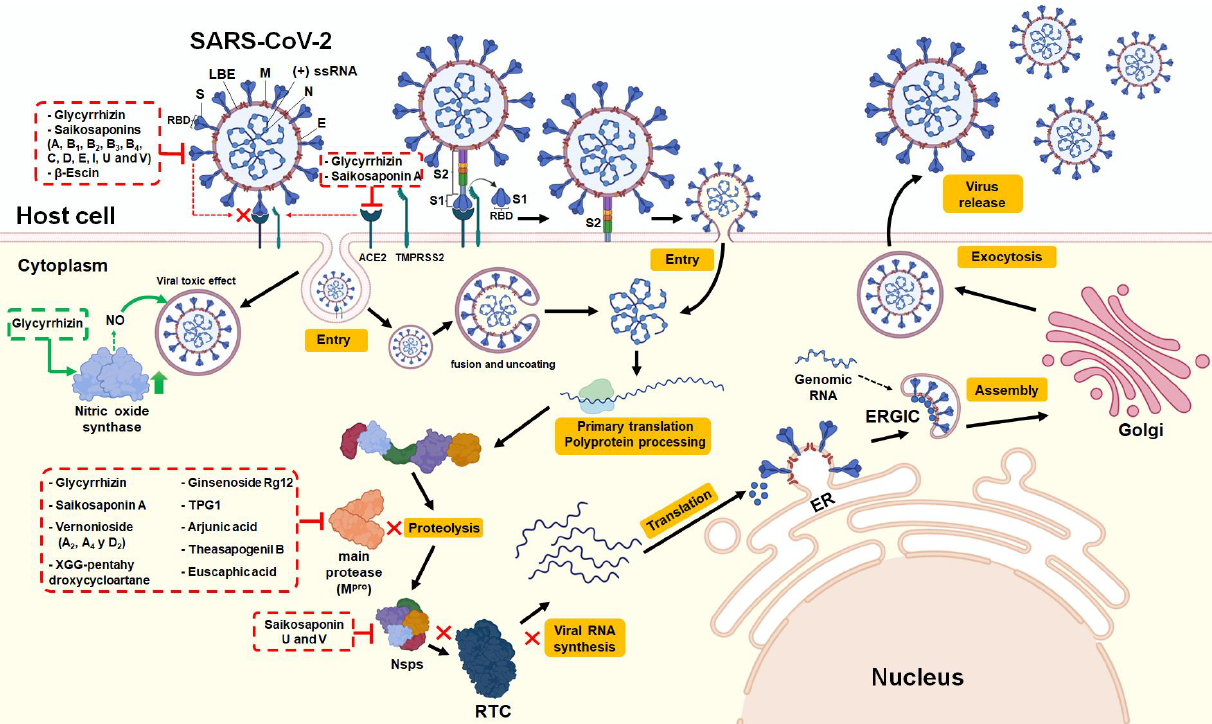
Figure 2. Viral replication cycle of SARS-CoV-2 and the effects of saponins on the viral pharmaco- logical targets. According to Mieres-Castro et al. [66], the structure of SARS-CoV-2 consists of a positive-sense single-stranded RNA genome (+ssRNA), a lipid bilayer envelope (LBE), and different structural proteins including spike or S protein, nucleoprotein (N), membrane protein (M), envelope protein (E), and hemagglutinin esterase (not shown in Figure). The +ssRNA is encapsulated by N, while M and E are incorporated during the viral assembly process. The replication cycle begins with the arrival of the SARS-CoV-2 to the target cell. The S protein binds to ACE2 and its receptor on the host cell; it is, then, cleaved by the cell surface serine protease TMPRSS2, forming two subunits, the S1 subunit containing the receptor-binding domain (RBD), and the S2 subunit containing the peptide for binding to the membrane-bound fusion protein of the host cell. This allows entry of the virus into the host cell, either by the formation of an endosome or by fusion of the viral enve- lope. After the fusion of the membranes of the virus and the host cell, viral RNA is uncoated and released into the cytoplasm in order to initiate the primary translation of co-terminal polyproteins (pp1a/ab) that perform the viral genome replication. After translation, the homodimeric cysteine protease M pro self-cleaves in order to cleave the polyproteins into Nsps. Different Nsps proteins interact with Nsp12 (also called RNA-dependent RNA polymerase (RdRp)) in order to form the replicase-transcriptase complex (RTC), which synthesizes the full-length viral genome (replication) and subgenomic RNA (transcription). The mRNAs of the viral structural proteins are translated and moved to the endoplasmic reticulum (ER). Genomic RNA is encapsulated with protein N and translocates with structural proteins in the ER-Golgi intermediate compartment (ERGIC) in order to form new virions. Finally, the new viruses are exocytosed from the infected cell and released into the extracellular space in order to infect other cells. The boxes indicate the effects of saponins on the different viral pharmacological targets (red boxes and arrows: inhibition; green boxes and arrows: stimulation). The antiviral mechanisms of action include: inhibiting viral spike glycoprotein and ACE2 in the host cell, thus preventing the binding and entry of the virus; stimulating nitric oxide synthase (iNOS) activity and increasing nitric oxide (NO) in order to cause toxic effects on the virus; and inhibiting M pro (binding to the active site), thus inhibiting the proteolysis of viral polyproteins that are necessary for virus replication, as well as binding to Nsp15 and the inhibition of its activity in the RTC complex for viral RNA synthesis and